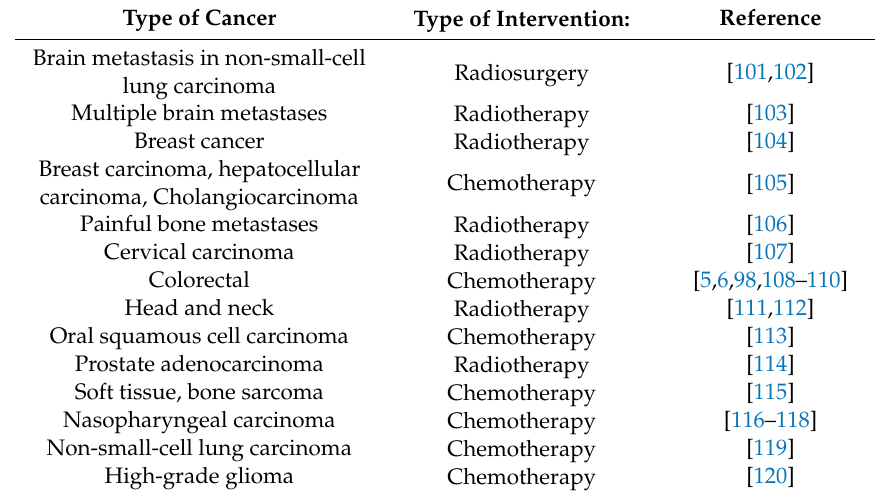
Table 3. Summary of clinical trials conducted to examine the e ff ect of time-of-day adjusted cancer